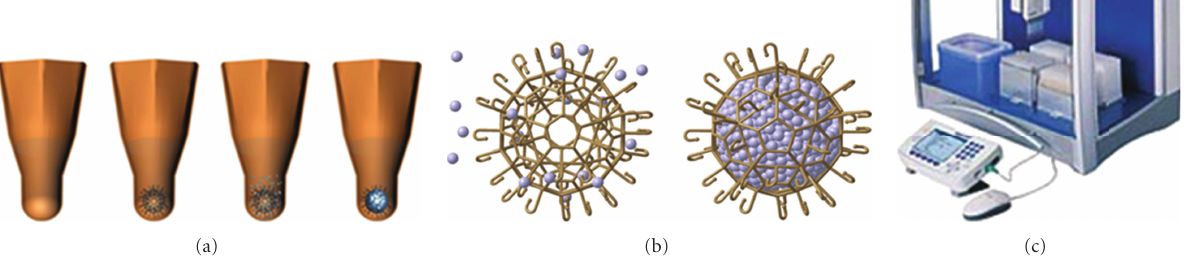
Figure 8: Robotic tissue spheroids biofabricator. (a) Scheme demonstrating sequential steps of encaging tissue spheroids in microsca ff old (lockyballs) in molded agarose hydrogel; (b) Scheme demonstrating cell seeding and tissue spheroid formation in lockyballs; (c) Robotic dispenser (Eppendorf, Germany).